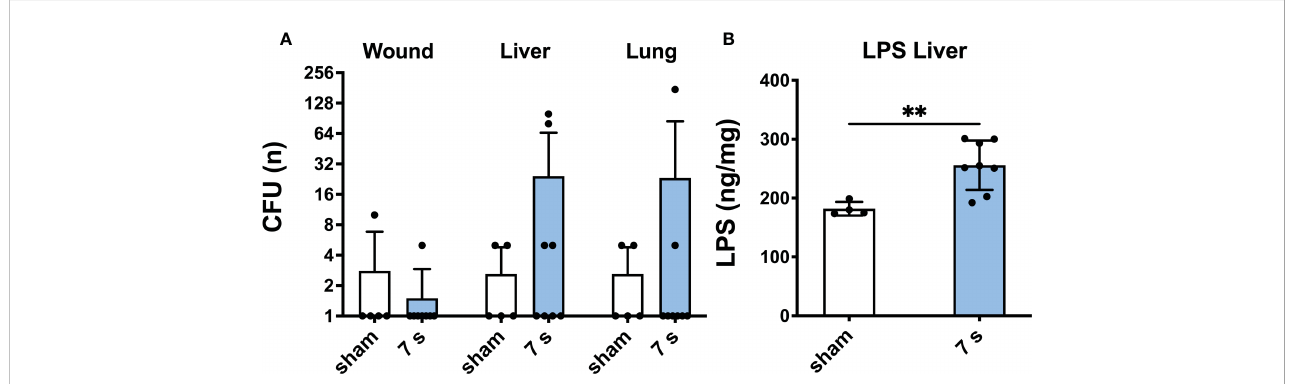
FIGURE 9 7 s scald induces bacterial translocation to liver and lung and an increase of LPS in the liver after 24 h. CFU (A) were examined in wound, liver, and lung samples. Results are provided as mean ± SD on a log 2 scale. LPS level in the liver (B) was quanti fi ed by means of ELISA. Results are provided as mean ± SD. For comparison, an unpaired t -test was performed. The level of signi fi cance: **p <